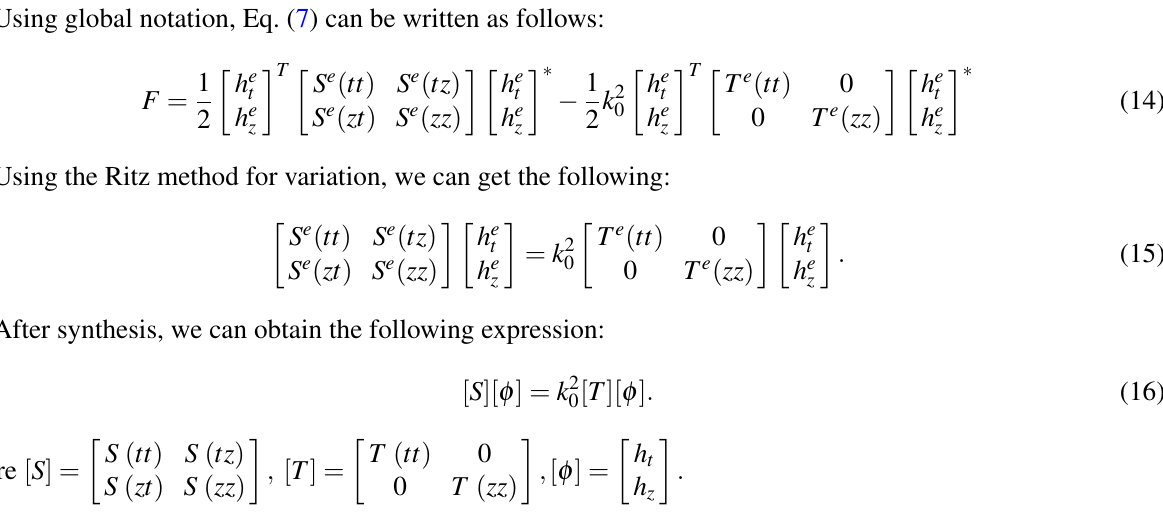
Table 1 Comparisons of calculation results of cutoff wave numbers of unilateral finline ( b / a = 0 . 5, d / b = 0 . 25, t / a = 0 . 01).